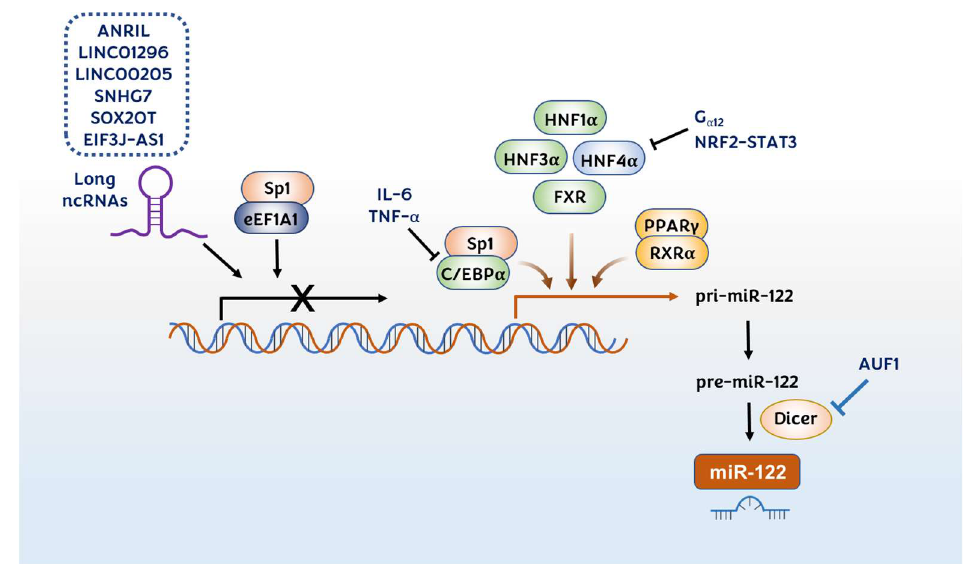
Figure 7. Upstream regulators of miR-122 in hepatocellular carcinoma. Long ncRNAs such as ANRIL, LINC01296, LINC00205, SNHG7, SOX2OT, and EIF3J-AS1 downregulate the transcription of miR-122. LETFs such as HNF1α, HNF3α, HNF3β, HNF4α, and C/EBPα, as well as PPARγ/RXRα